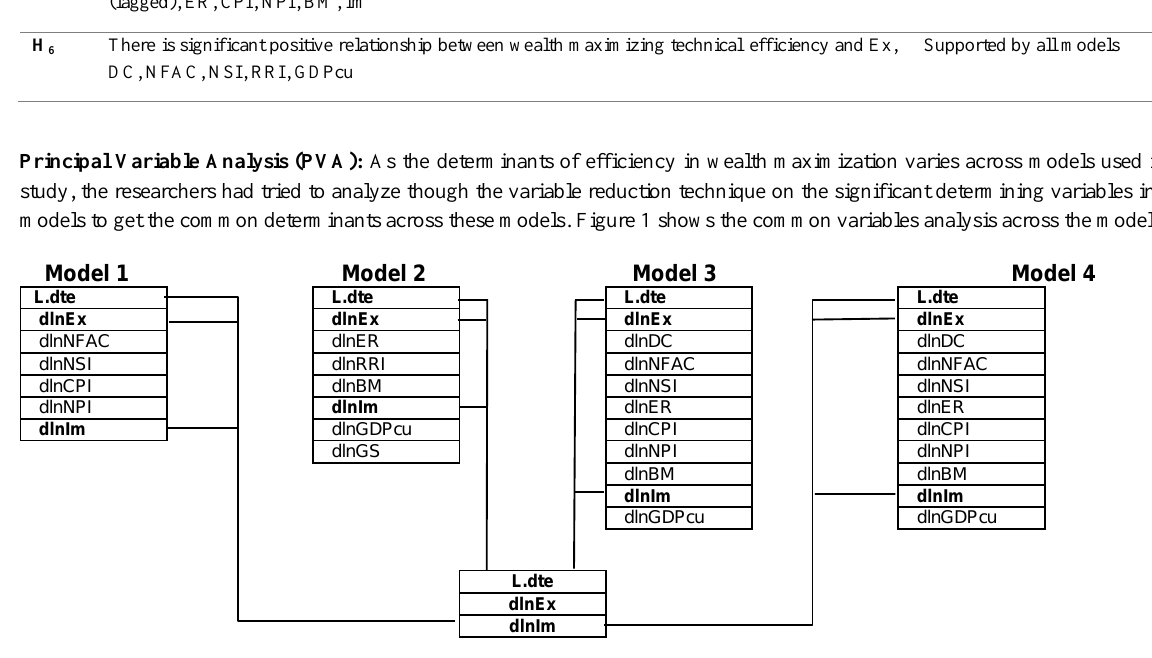
Figure 1 : Common variables analysis across the